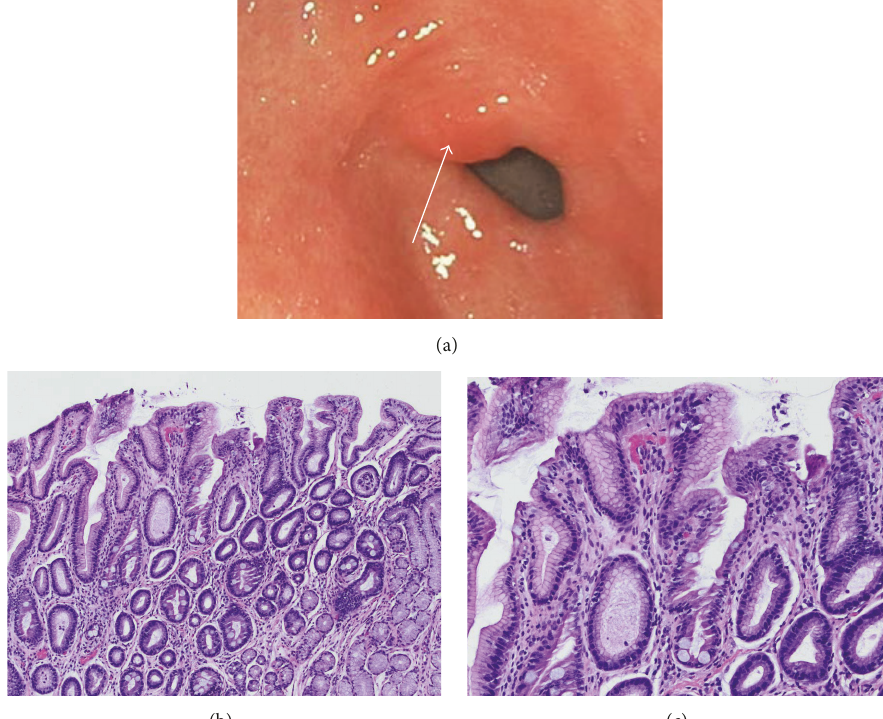
Figure 2: Endoscopic and histologic appearance of gastrointestinal metaplasia in case 2. (a) shows the appearance of a prepyloric nodule with an erosion located on the lesser curvature of the antrum. A cold forceps biopsy was taken from a region adjacent to the erosion (arrow). (b) shows a low power image and (c) shows a high power histopathology image of the prepyloric nodule in case 2. The lamina propria is distended by a chronic inflammatory cell infiltrate, irregular columnar cells filled with mucin, and an absence of brush border is noted, signifying an incomplete